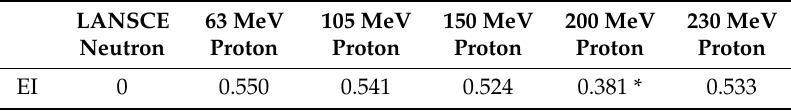
Table 4. EI for secondary particle yields in layer structure with SiGe.